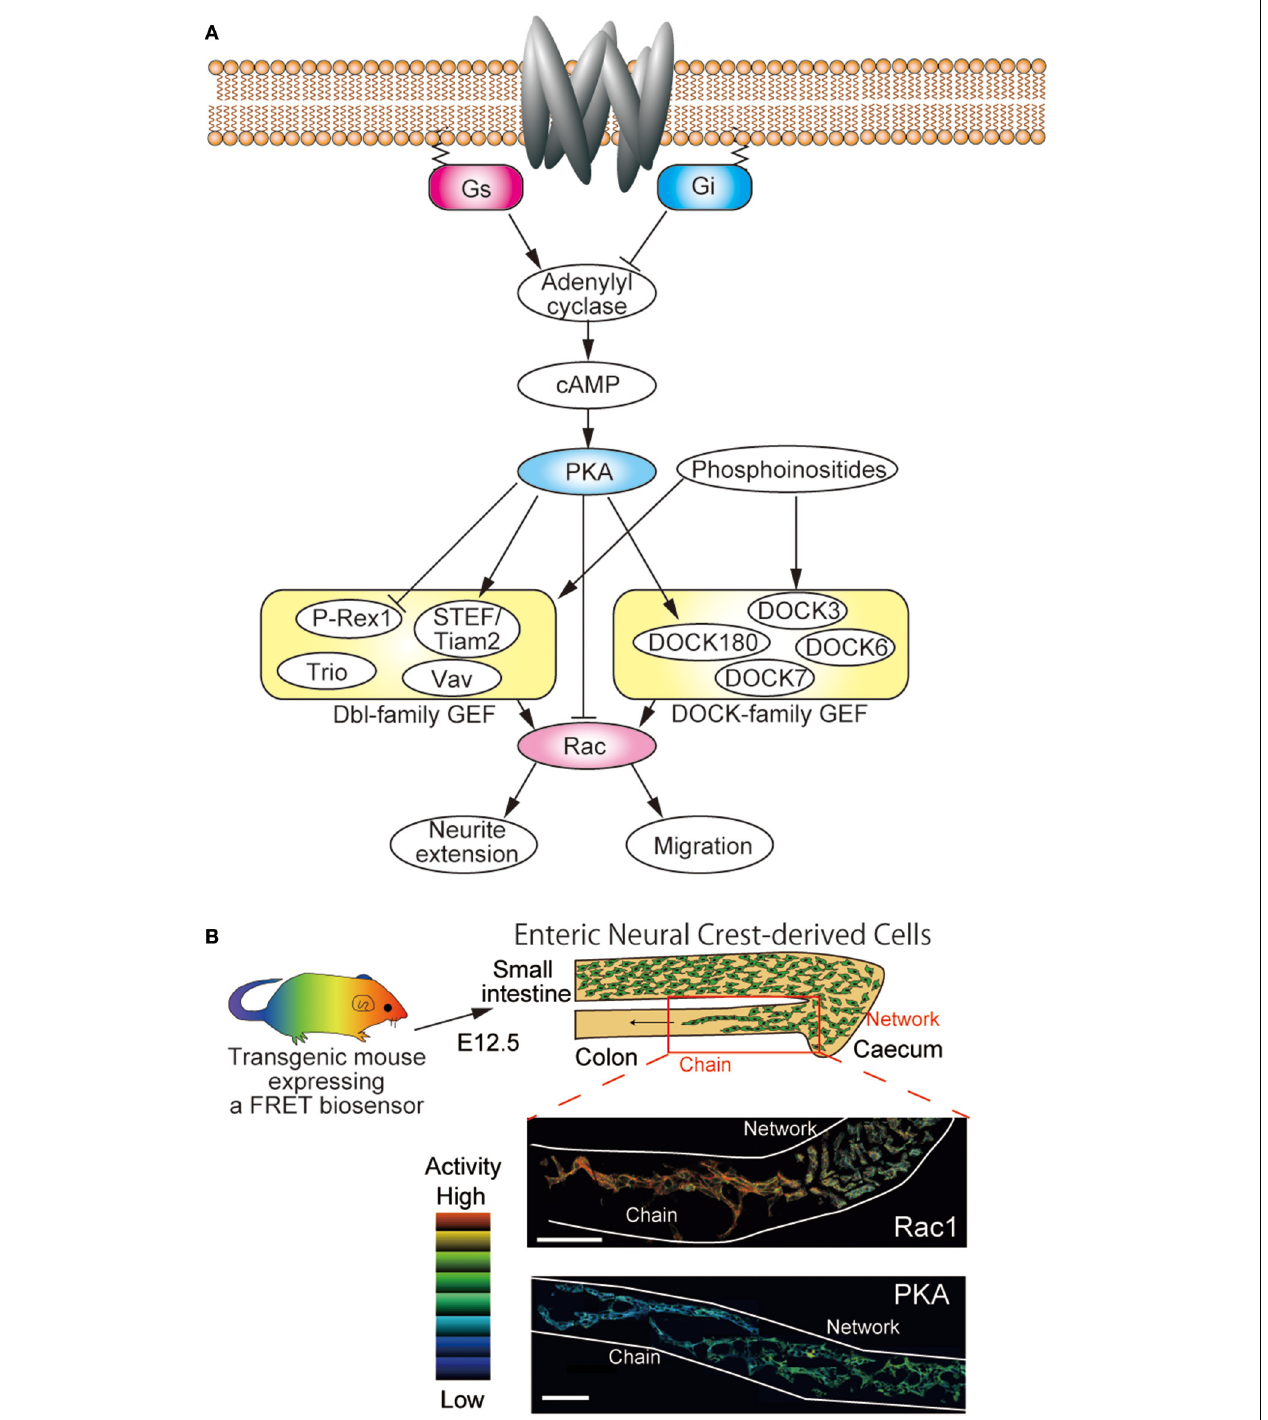
FIGURE 1 | Regulation of Rac by PKA in neuronal cells. (A) Schematic view of the regulatory network of Rac in neuronal cells. Neuronal cells express both Dbl-family and DOCK-family GEFs. Among them, P-Rex1, STEF/Tiam2, and DOCK180 have been shown to be phosphorylated by PKA. Rac activity is required for neurite extension, migration, and so on. (B) Transgenic mice expressing FRET biosensors can be used to examine the in vivo activities of Rac1 and PKA. Embryonic intestines of E12.5